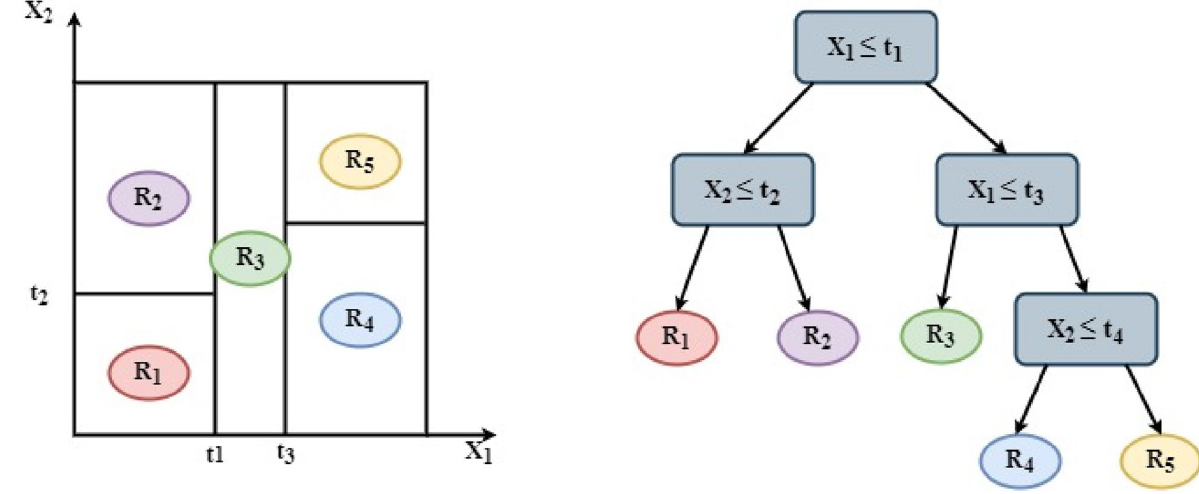
Figure 2. Schematic representation of regression tree.